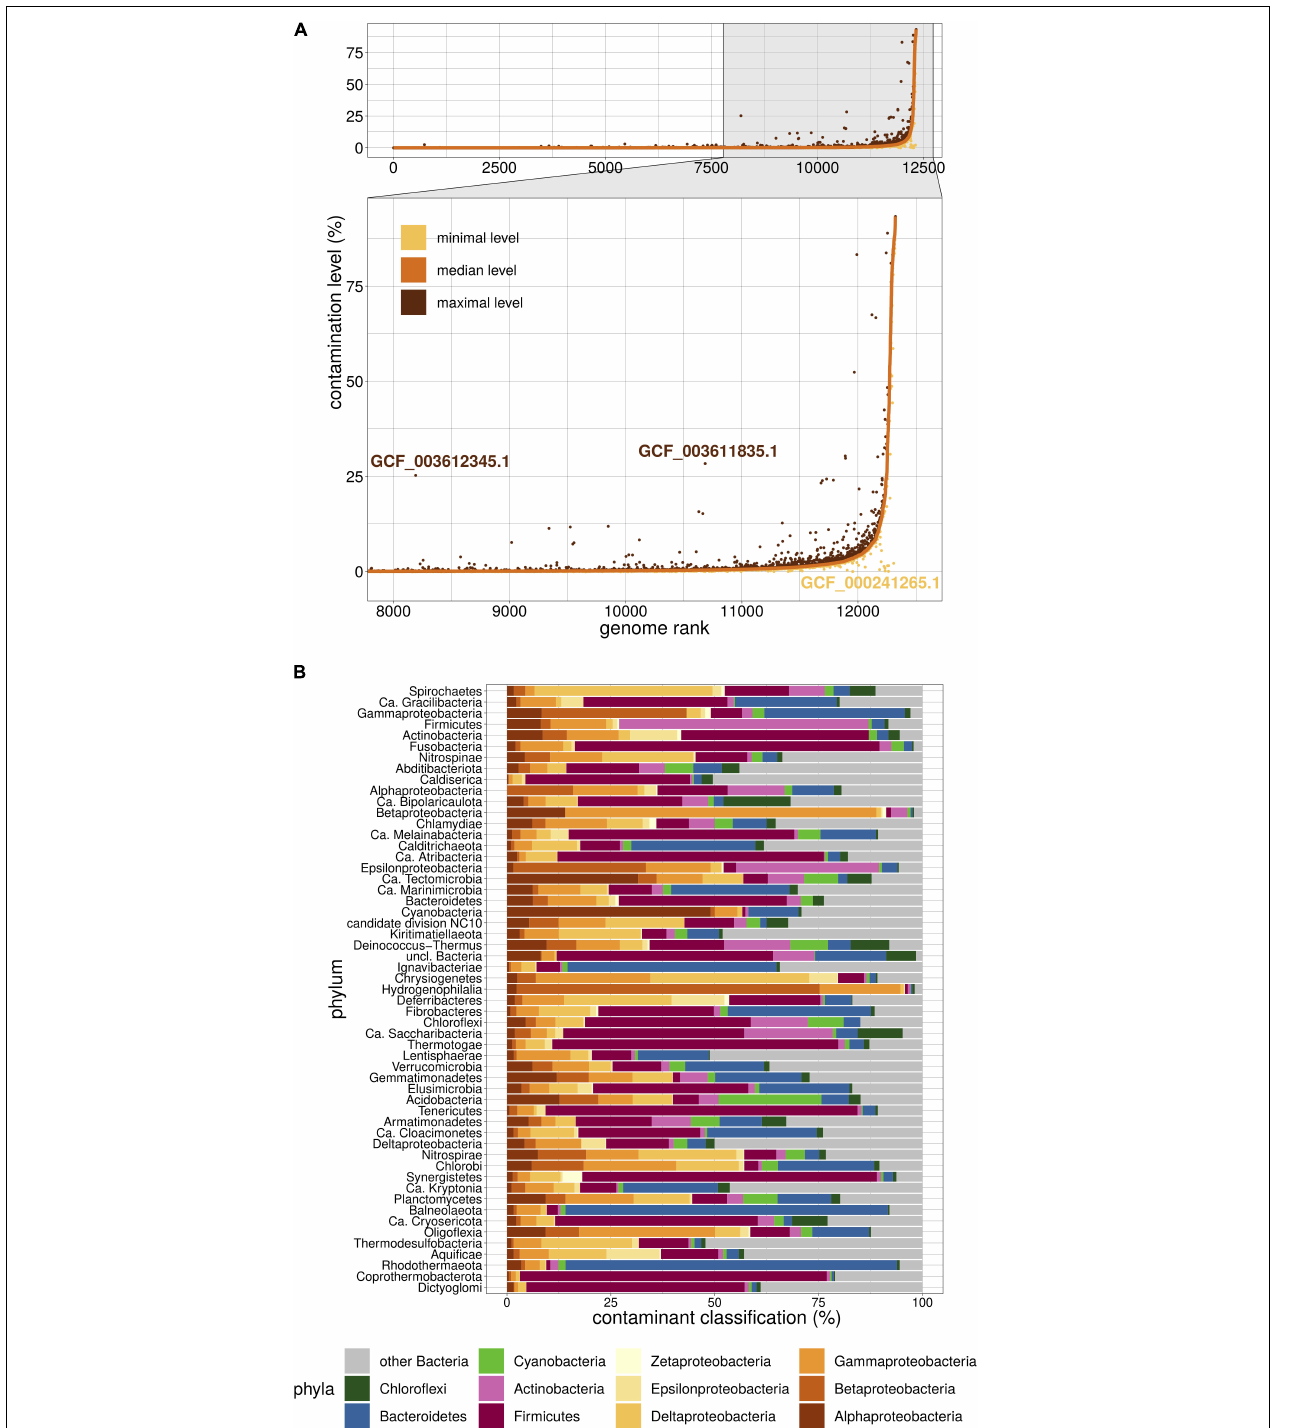
FIGURE 2 | Overview of Physeter properties. (A) Distribution of contamination levels assessed by Physeter in k -fold mode. Genomes are ranked from the lowest to highest median level of contamination. Median levels are shown in a solid orange line, while minimal and maximal levels are represented as yellow and brown dots, respectively. GCF_003612345.1 and GCF_003611835.1 are examples of genomes having a low median level of contamination with some independent estimations showing a higher contamination level. The opposite case is illustrated with GCF_000241265.1. (B) Taxonomic distribution of contaminating sequences within each phylum. The relative contributions of each contaminating phylum were first averaged by genome over all 10 k -folds, then these genome-wise averaged values were averaged by tested phylum over all genomes.